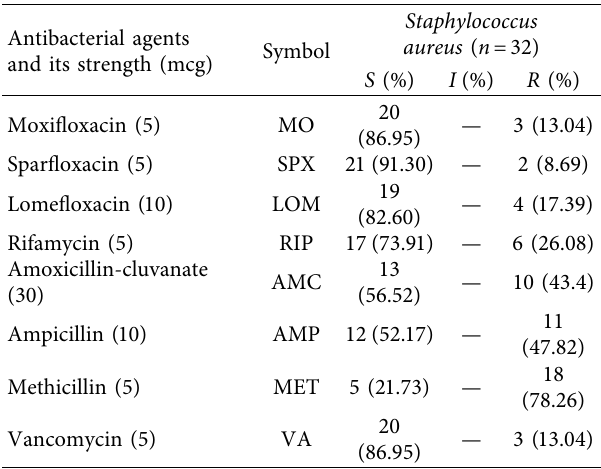
Table 4: Antimicrobial susceptibility profles of Staphylococcus aureus at the Wolaita Sodo University wastewater treatment